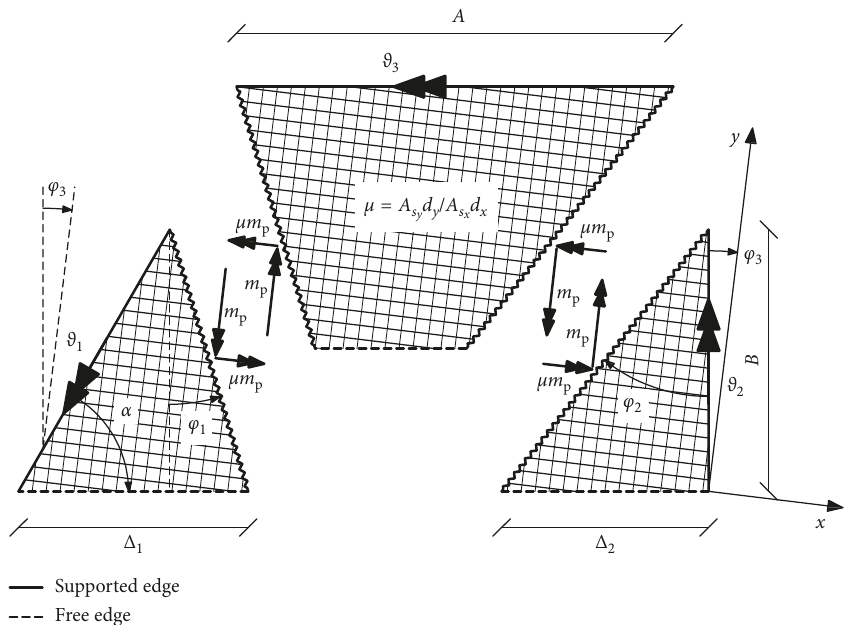
Figure 9: Slab regions with the reinforcement at an angle to the free edge.